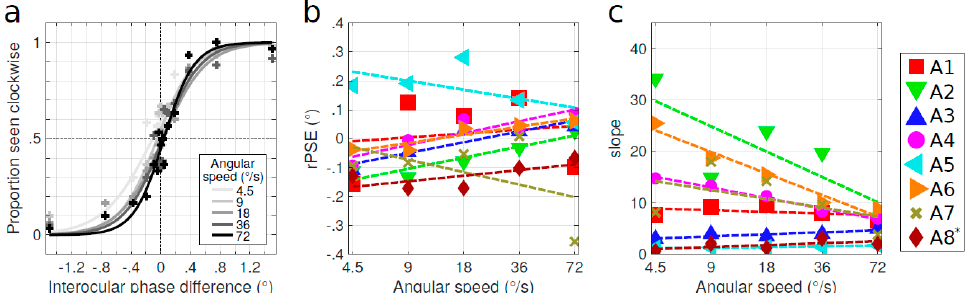
Figure 7. Effect of speed. ( a ) Psychometric functions of the perceived direction of rotation for one amblyopic subject (A3) as a function of the interocular phase difference for different rotation angular speeds of the stimulus: 4.5, 9, 18, 36, and 72 °/s (from light gray to dark gray). Data points are fitted by a logistic function. ( b ) rPSE as a function of the angular speed for the eight amblyopic subjects. * rPSE values for subject A8 were divided by 10. ( c ) Slopes of the psychometric functions. Dashed lines represent linear regression. Quality of fit and regression parameters are reported in Table S1 (Supplementary Materials, Sheet 3).